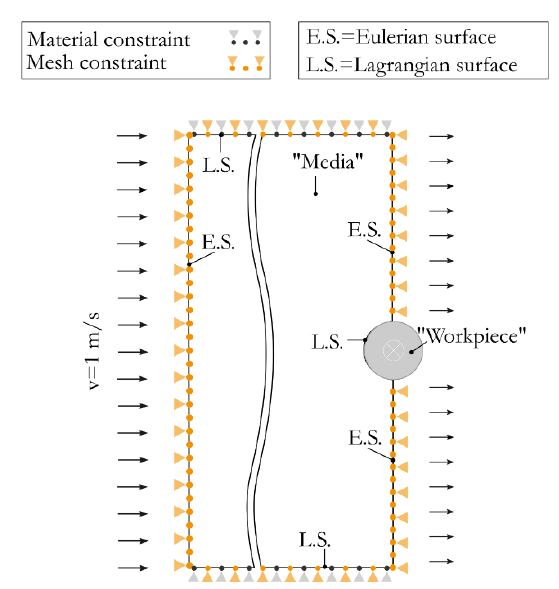
Figure 4. Schematic figure of the numerical model.